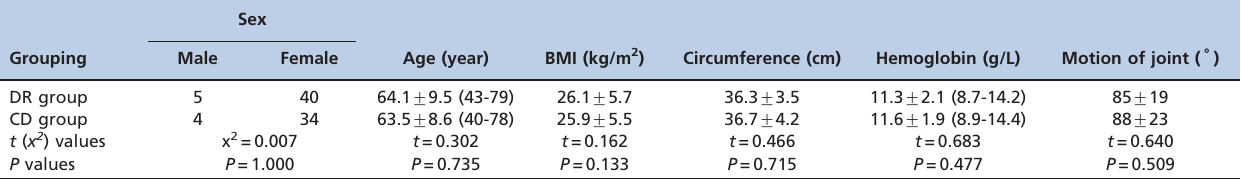
Table 1 - Preoperative Parameters in Both Groups (mean ¡ SD or